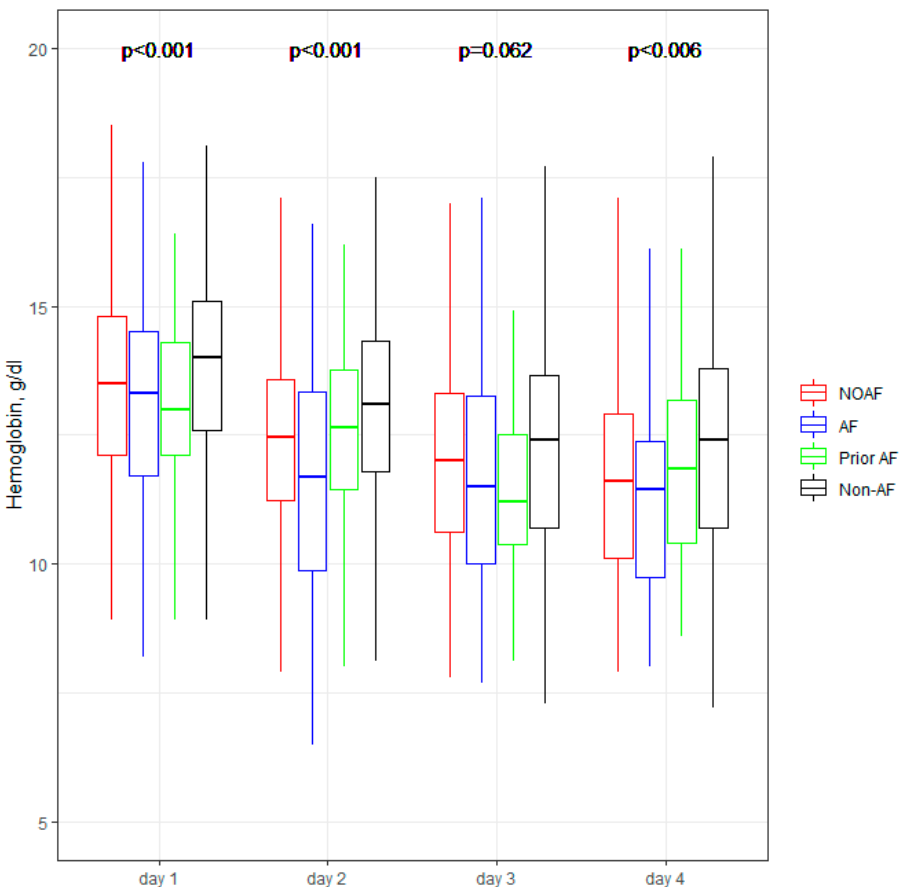
Figure 5. Hemoglobin within the first four days of hospitalization. The center represents the median value. The upper and lower quartiles values are displayed with whiskers. p -values on the figure represent the group changes (the Kruskal–Wallis test). The time changes were calculated by the Friedman test and paired samples Wilcoxon test with Bonferroni adjusted ( p < 0.001). NOAF—group of patients with any newly diagnosed AF that appeared during AMI hospitalization; AF—group of patients with a previously documented diagnosis of AF who additionally had AF during AMI hospitalization; Prior AF—group of patients with a previously documented diagnosis of AF who had not developed AF during AMI hospitalization; Non-AF—group of patients with no evidence of AF during AMI hospitalization and without the prior AF